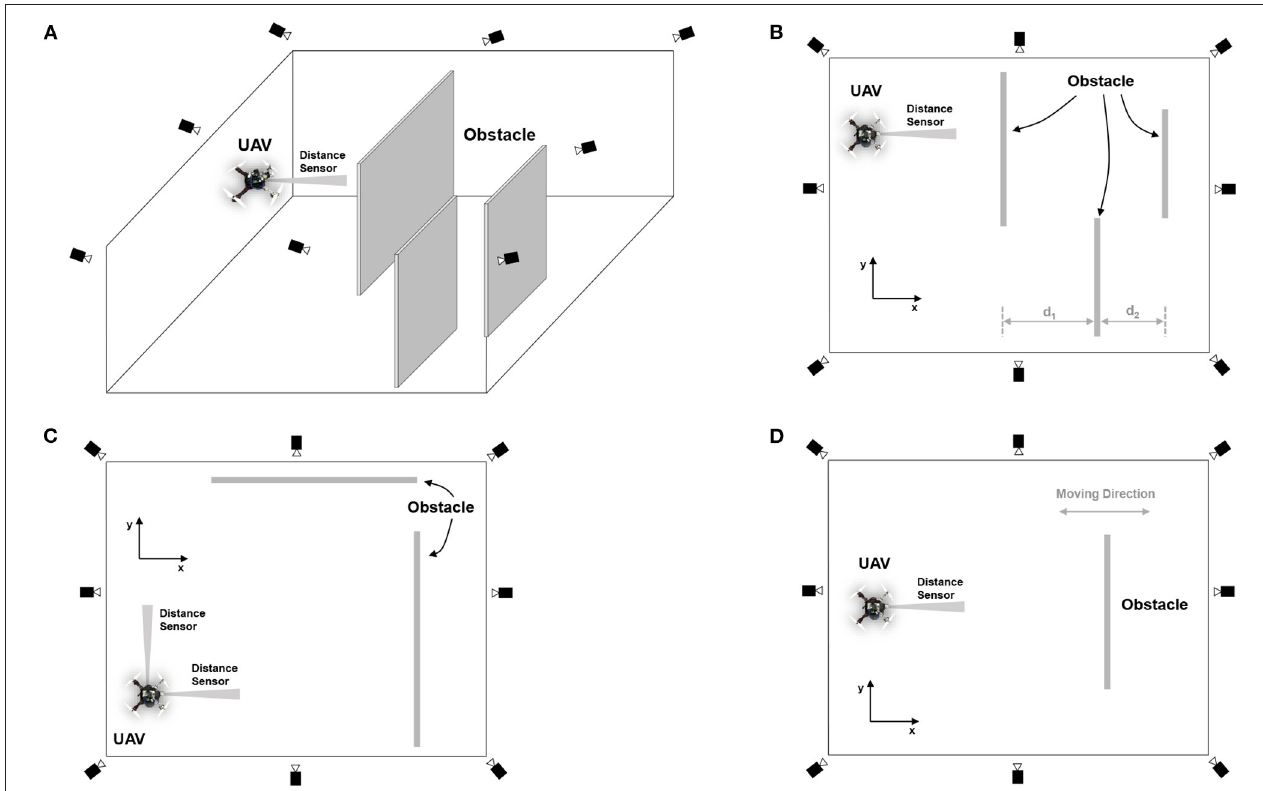
FIGURE 13 | Experimental setup for speed adaptation and reactive obstacle avoidance in the real environment. (A) 3D view of the indoor environment for flying the UAV under a localization system, consisting of eight motion capture cameras. (B) Top view of the environment, showing the detection ranges and parameter setting when using the speed adaptation algorithm for obstacle avoidance. In this setup, three obstacles were placed in sequence with the distances d1 and d2 set to 2.0 and 1.5 m, respectively. To detect the obstacle, we used the distance sensor installed at the front of the UAV. Note that we used the information obtained from the localization system (motion capture) for the altitude or z position control of the UAV. (C) Top view of the environment showing obstacles placed in both x and y directions of the UAV. (D) Top view of the environment showing the movable obstacle placed in the x direction of the